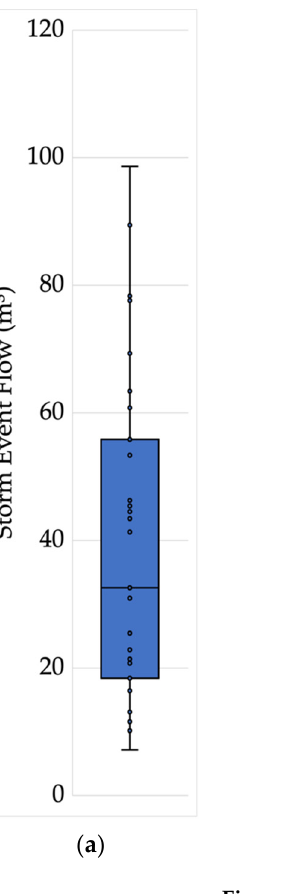
Figure 2. Distribution of hydrologic statistics from all storm events that were sampled and included in the analysis (n = 43), including ( a ) the total flow from each discrete storm event, ( b ) peak 10-min recorded flow rate during each storm event, and ( c ) duration of the storm event defined by the first and last sample collected. ( d ) The distribution of flow-weighted contact time for storm events in which the piezometer was installed to monitor water levels (n = 18).